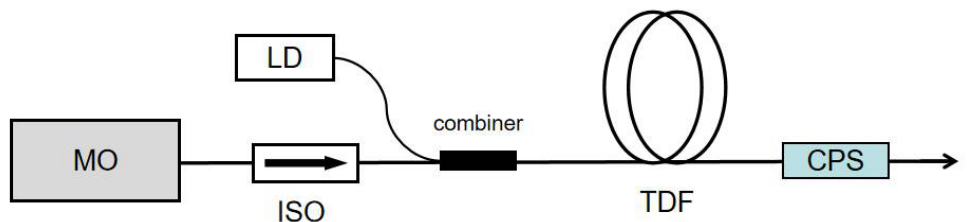
Figure 2. Layout of the all-fiber single-mode wavelength-tunable narrow-linewidth polarization- maintaining (PM) Tm-doped fiber power amplifier. MO: master-oscillator; LD: laser diode; TDF: Tm-doped fiber; ISO: isolator; CPS: cladding power stripper.